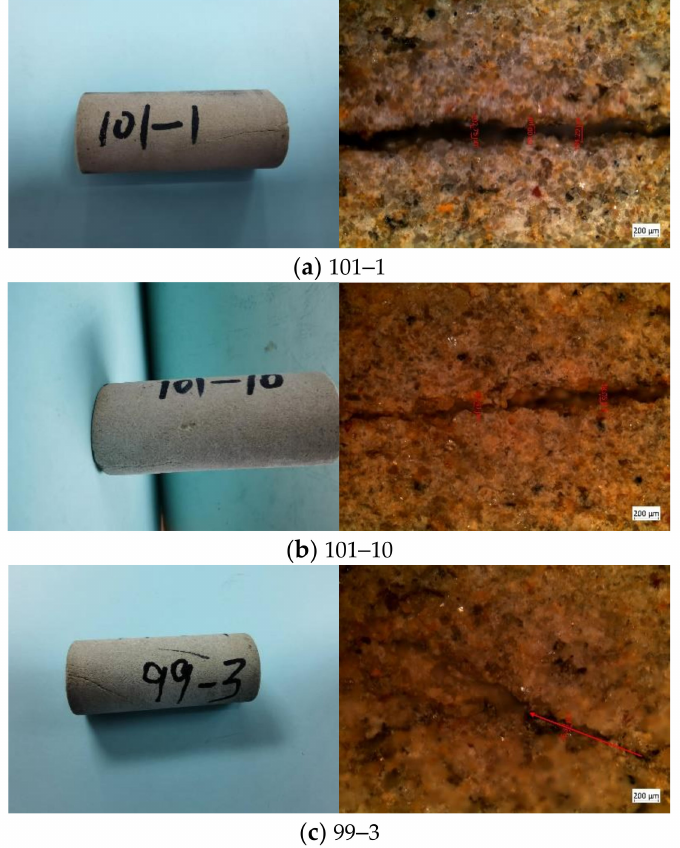
Figure 8. Observations under a microscope of three cores with cracks on the surface.